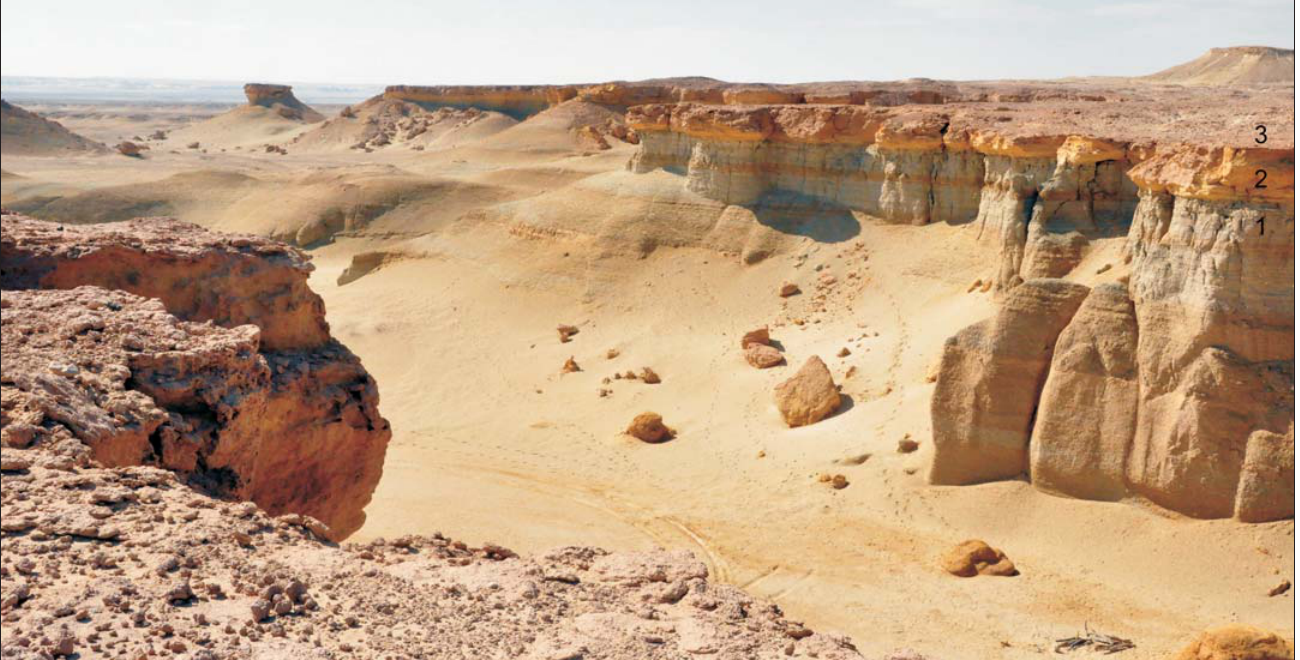
Fig. 4. Upper part of the Daba’a Formation (late Eocene) at Minqar Tibabaghbagh, Qattara Depression, Egypt (1), overlain by a thick brownish sandstone layer (2), on top of it the deflation surface and the BOTM (3). Point of view: E 26°26.360’, N 29°10.772’.